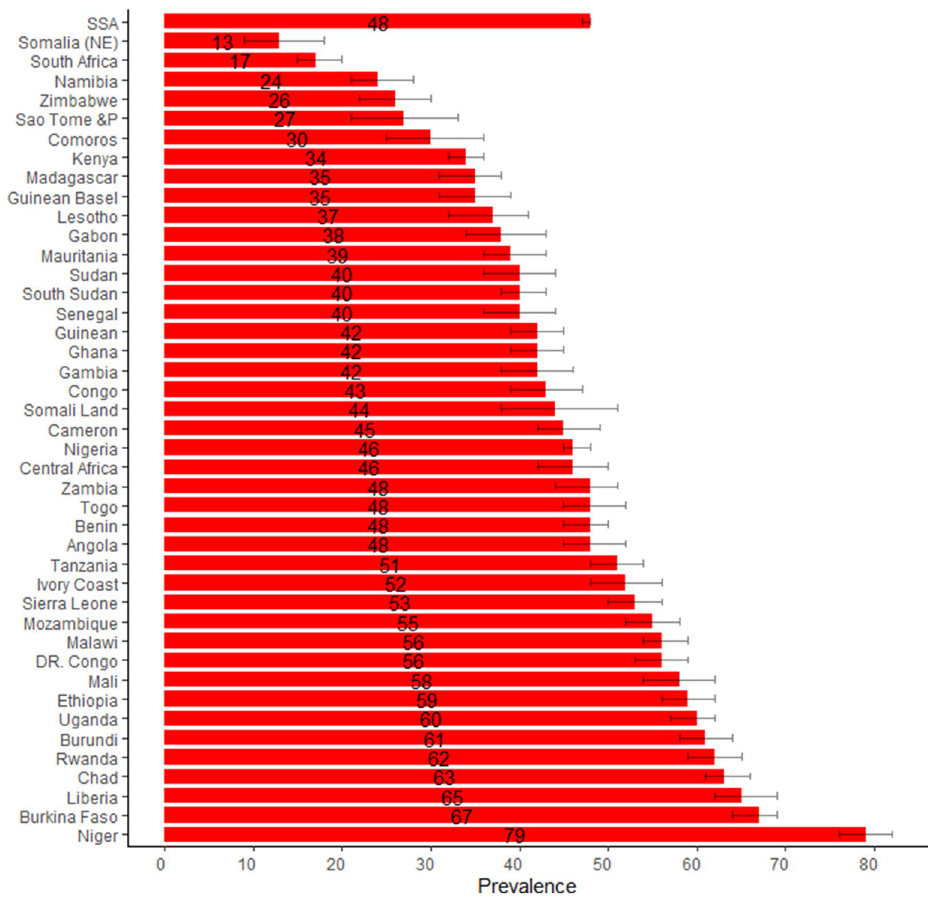
Figure 3. The proportion of women aged of 45–49 years who suffer at least one child death with confidence interval. All analysis of bar graph and confidence interval was used R soft wear (version R